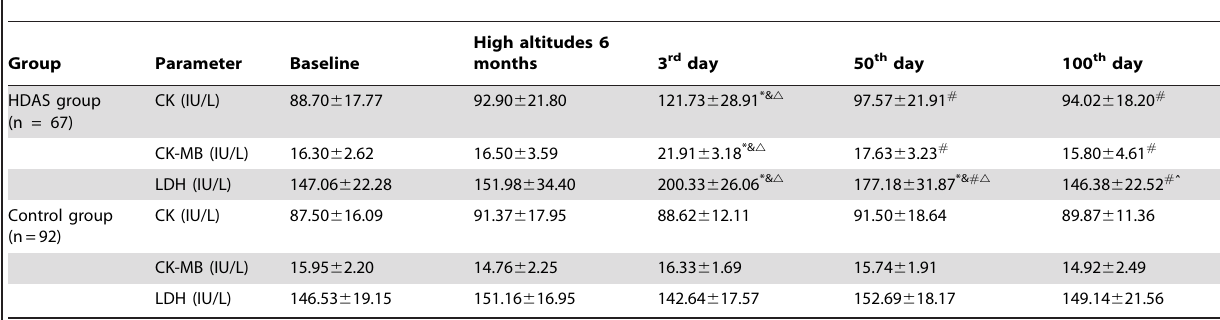
Table 8. Serum CK, CK-MB, and LDH of subjects after returning to Chongqing.